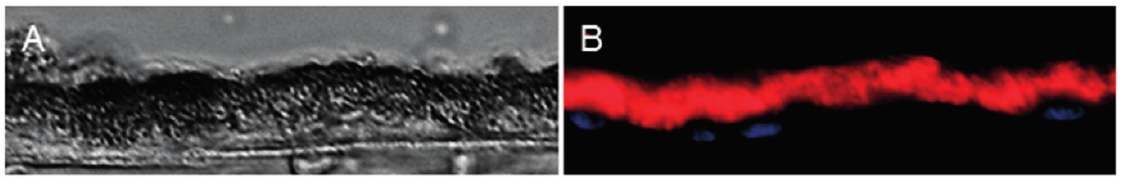
Figure 5. Peripherin 2 (red) expression in healthy human RPE. ( A ) Differential interference contrast image of healthy human RPE; ( B ) peripherin 2 (red) was expressed over the whole RPE layer with an even